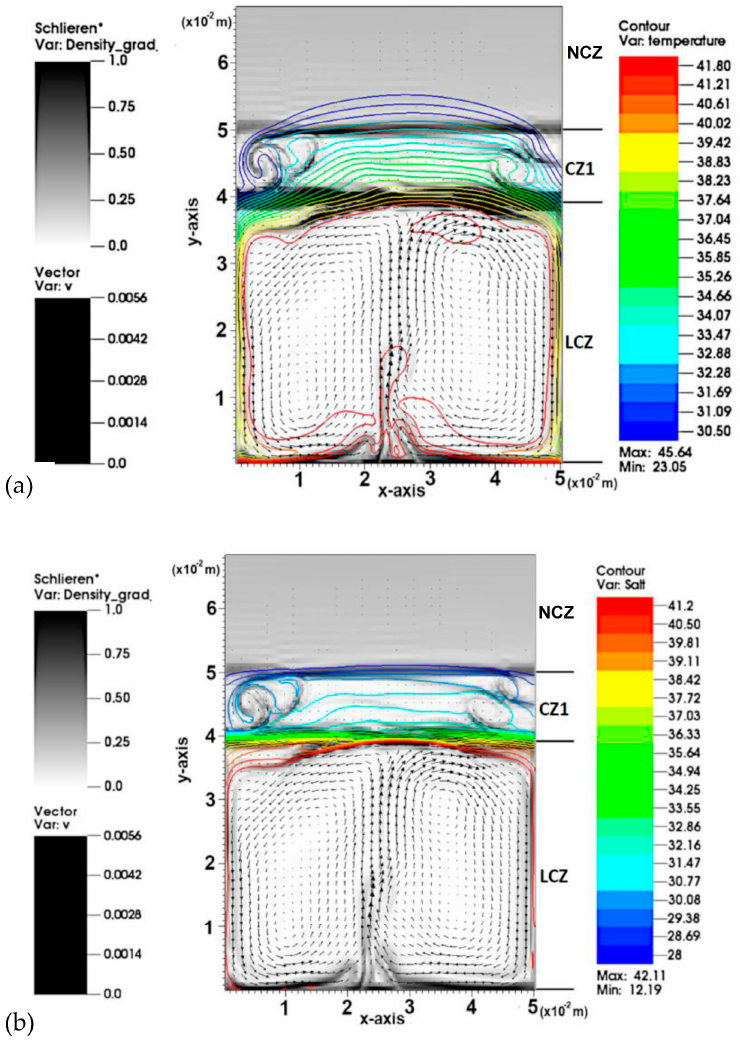
Figure 8. Schlieren image at t = 4680 s overlayed with the predicted velocity field and ( a ) temperature contours or ( b ) salinity contours.